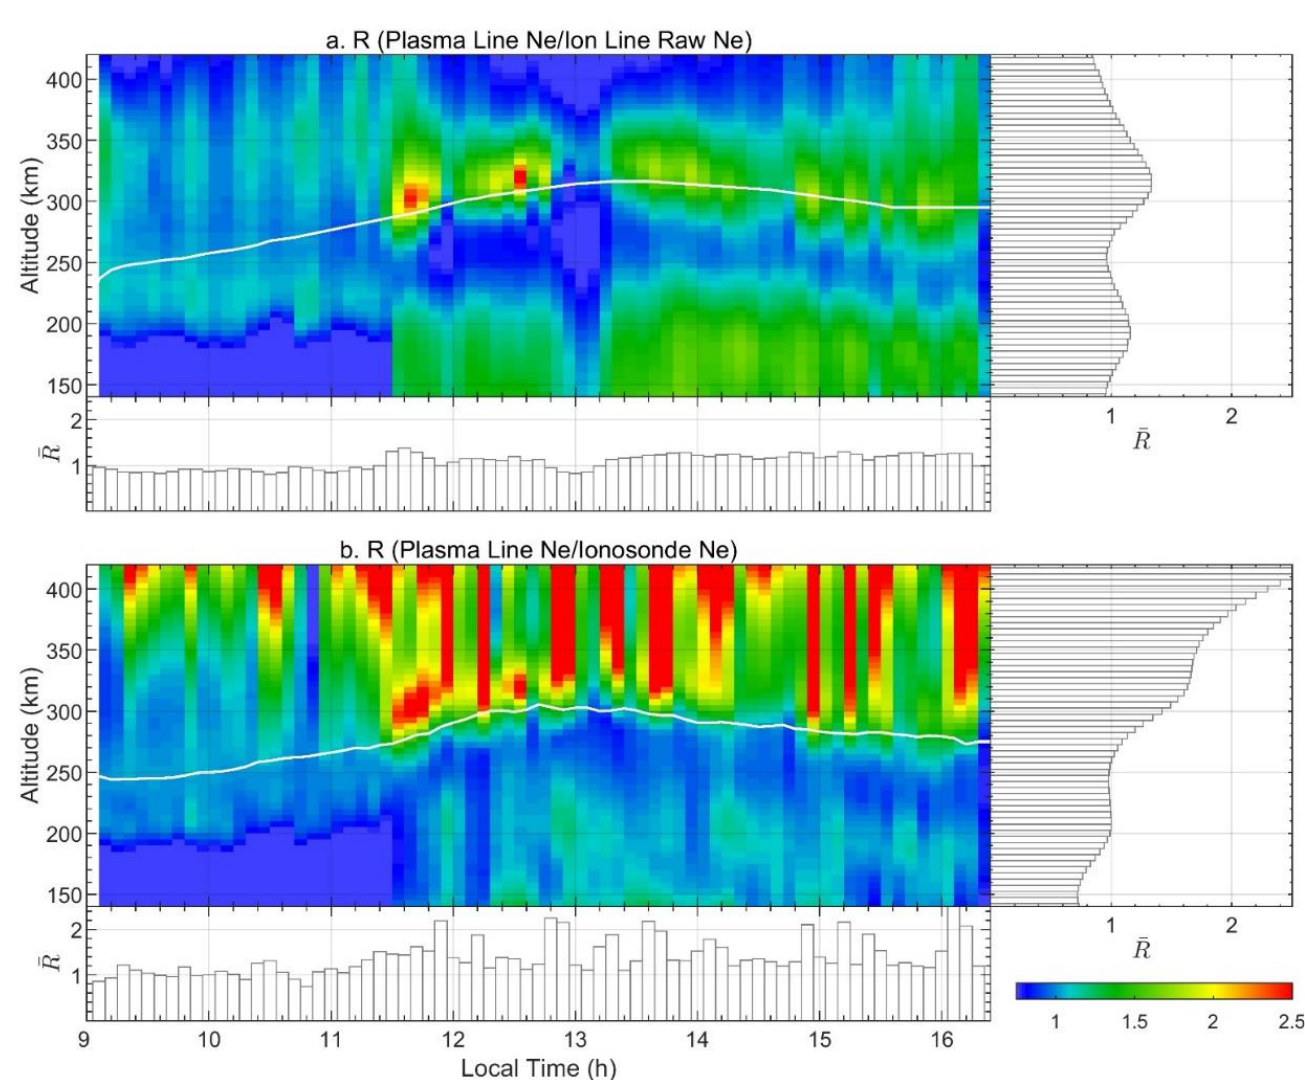
Figure 3. The ratio of plasma line-derived electron density to ion line derived raw electron density ( a ) and plasma line-derived electron density to ionosonde electron density ( b ) during 28 December 2021. The white line in each colormap represents the corresponding ionospheric peak height. The mean ratio variations versus local time and altitude are, respectively, shown in the bottom and right